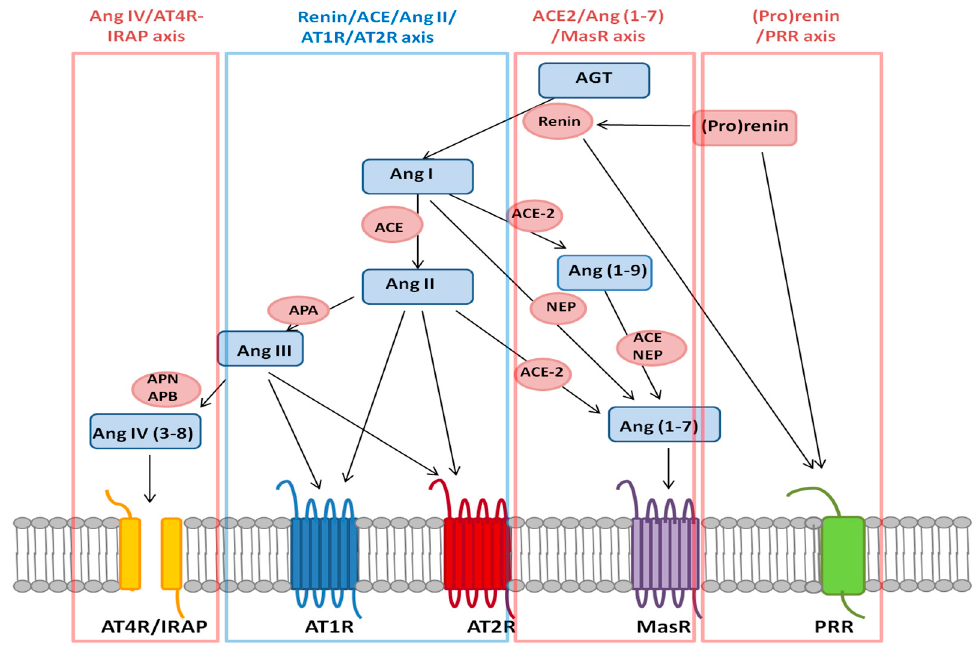
Figure 1. Current view of the RAS. Canonical or systemic pathway is shown in blue, while the no-canonical axes are shown in red. Peptide abbreviations: AGT, angiotensinogen; Ang I, angiotensin I; Ang II, angiotensin II; Ang III, angiotensin III; Ang IV, angiotensin (3–8) or IV; Ang (1–9), angiotensin (1–9); Ang (1–7), angiotensin (1–7). Receptor abbreviations: AT1R, Ang II receptor type 1; AT2R, Ang II type 2 receptor; AT4R / IRAP, Ang IV receptor; MasR , Ang receptor (1–7) or Mas receptor; PRR, (pro)renin receptor. Enzyme abbreviations: ACE, angiotensin-converting enzyme; ACE2 , angiotensin-converting enzyme 2; NEP, neutral endopeptidase; APA, aminopeptidase A; APN, aminopeptidase N; APB, aminopeptidase B.